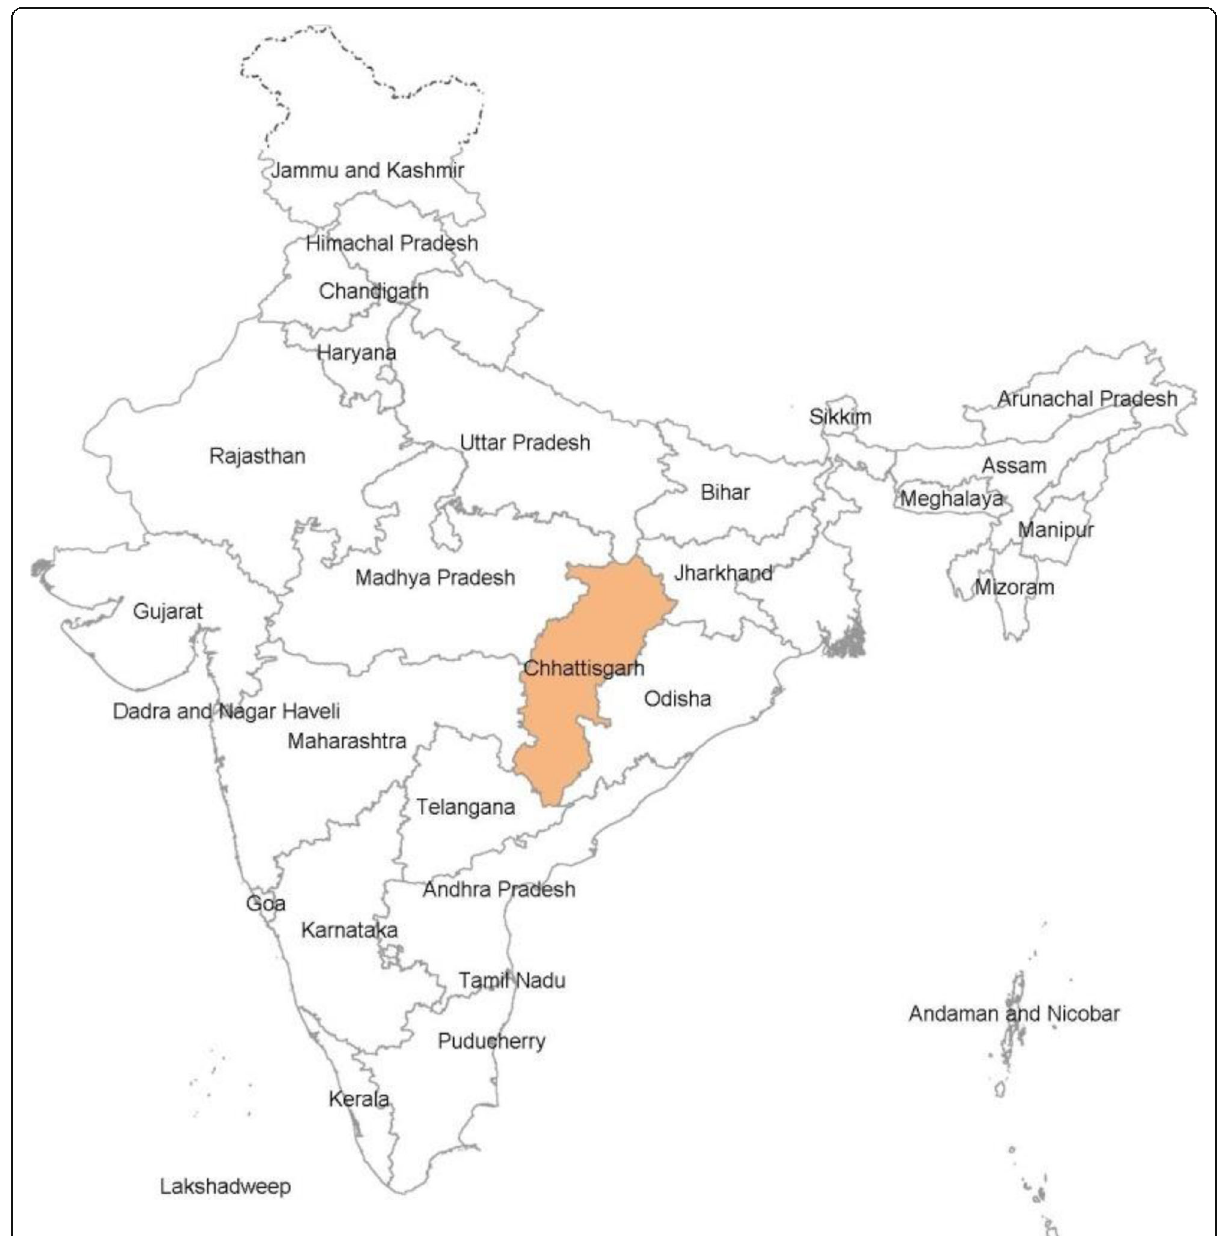
Fig. 1 Map of India showing Chhattisgarh and other